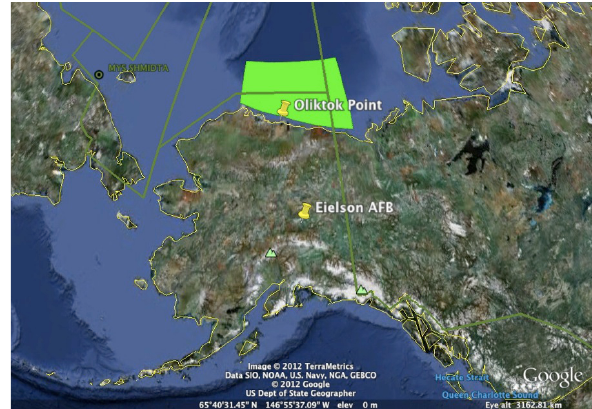
Figure 6. Area of Investigation in the Beaufort